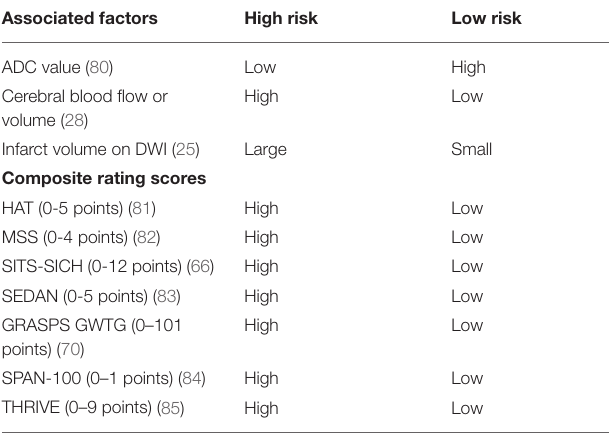
TABLE 2 | Various associated factors with